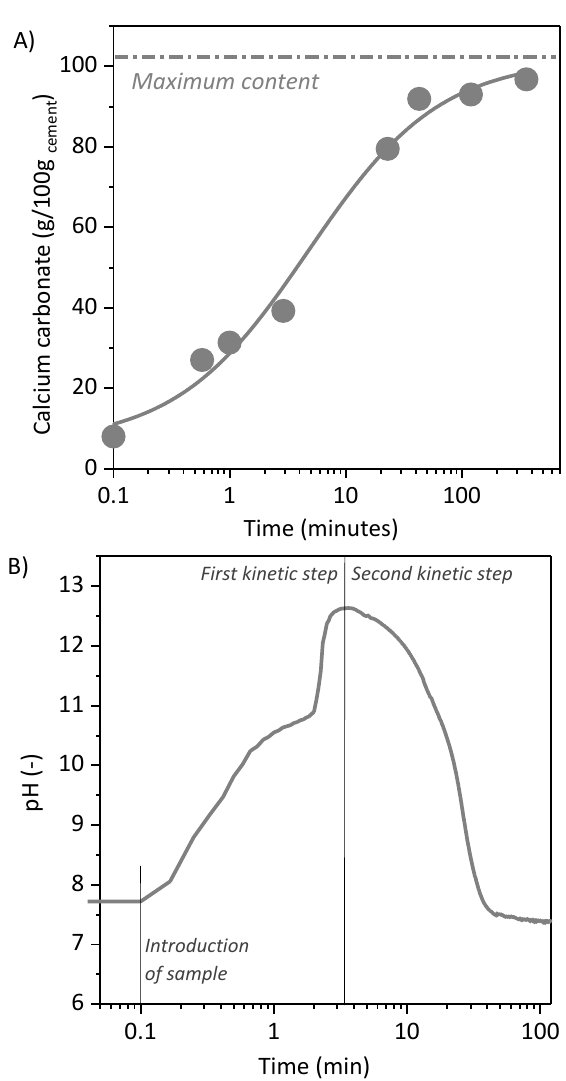
Figure 4. (A) Evolution of the calcium carbonate content during carbonation of the ground Portland cement pastes in a wet reactor with a 10% CO 2 – 90% N 2 gas flow at 10 L/hr/1g cement at T = 20 °C and normal pressure. The line is a guide for eye. (B) Evolution of pH during the carbonation